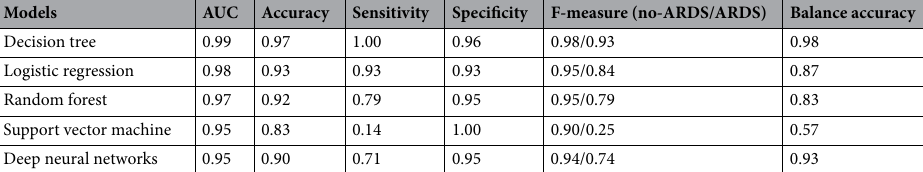
Table 6. Performance of the five algorithms on external testing dataset in predicting the occurrence of COVID-19 ARDS.